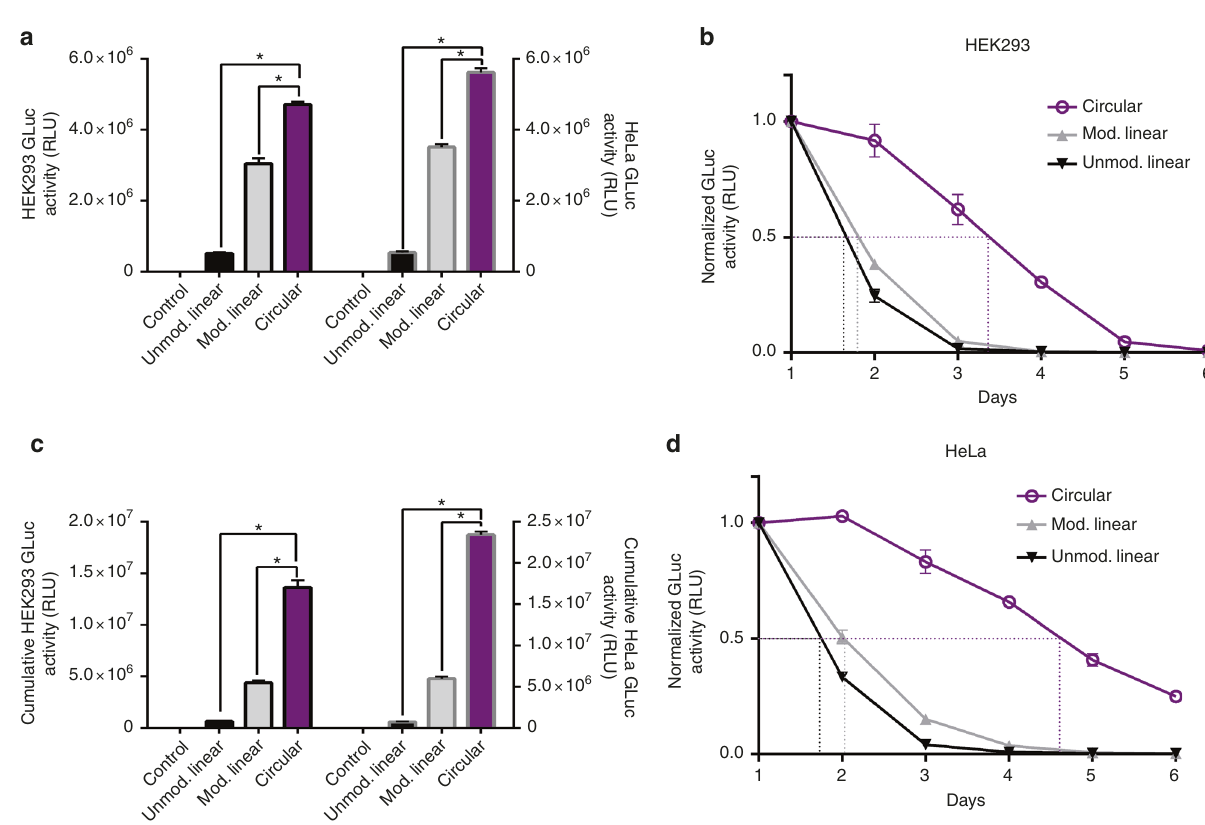
Fig. 6 Translation ef fi cacy of circRNA compared to linear mRNA. a Luminescence in the supernatant of HEK293 (left, black outline) and HeLa (right, gray outline) cells 24 h after transfection with CVB3-GLuc-pAC circRNA or modi fi ed or unmodi fi ed linear GLuc mRNA ( n = 4 HEK293, n = 3 HeLa). b Luminescence in the supernatant of HEK293 cells starting 24 h after transfection with CVB3-GLuc-pAC circRNA or modi fi ed or unmodi fi ed linear GLuc mRNA and continuing for 6 days ( n = 4). c Relative cumulative luminescence produced over 6 days by HEK293 (left, black outline) and HeLa (right, gray outline) cells transfected with CVB3-GLuc-pAC circRNA or modi fi ed or unmodi fi ed linear GLuc mRNA ( n = 4 HEK293, n = 3 HeLa). d Luminescence in the supernatant of HeLa cells starting 24 h after transfection with CVB3-GLuc-pAC circRNA or modi fi ed or unmodi fi ed linear GLuc mRNA and continuing for 6 days ( n = 3). (all data presented as mean + SD, * p < 0.05 (Welch ’ s t